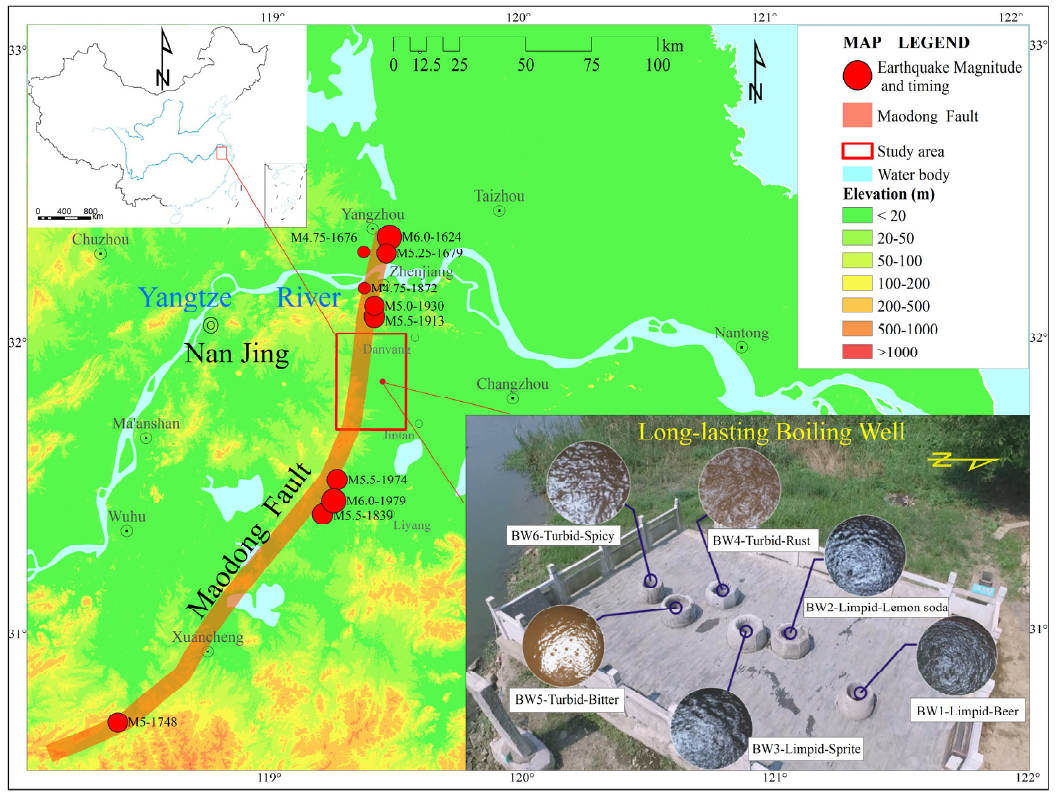
Figure 1. Distribution of destructive earthquakes at the Maodong Fault and the location of the six Long-lasting Boiling-Wells in the Jizi temple (Jiuli